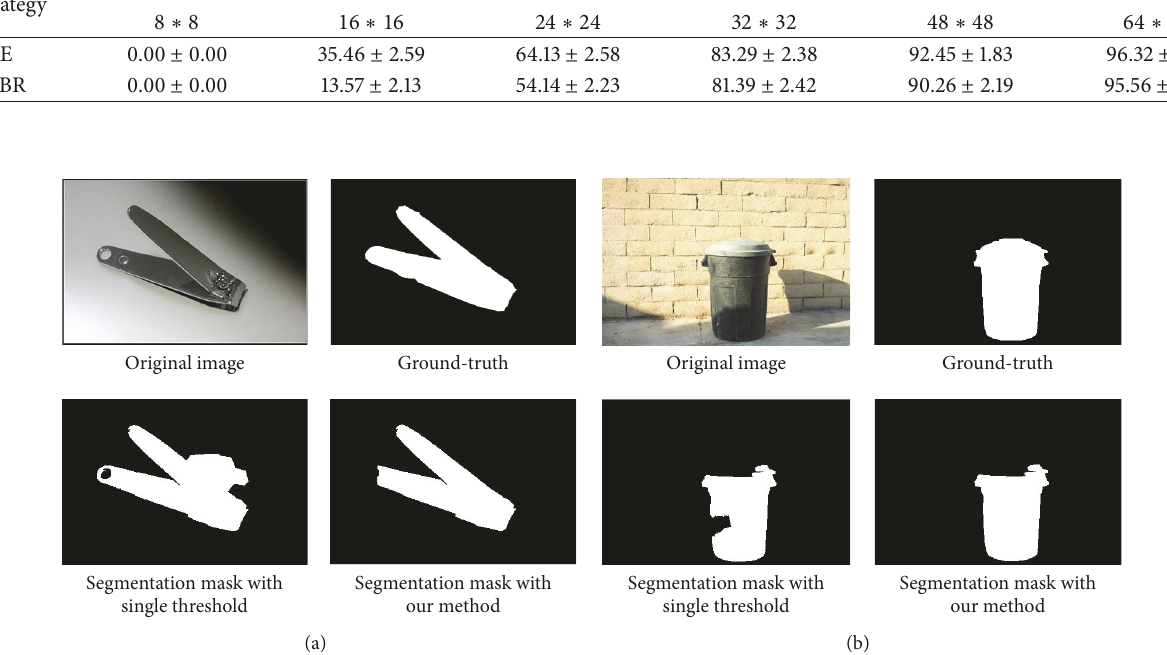
Figure 8: Comparison of different saliency segmentation method: (a) example image “nail clippers” and (b) example image “dust bin.”